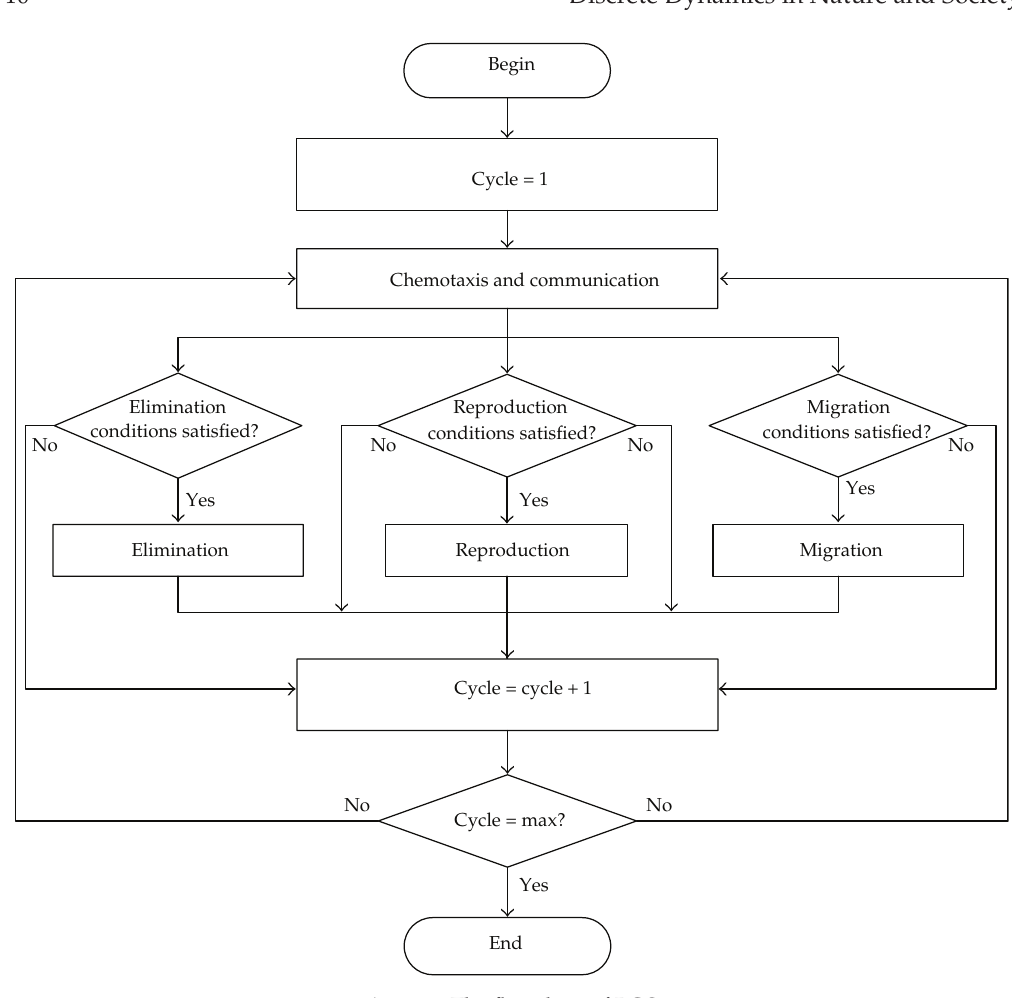
Figure 5: The flowchart of